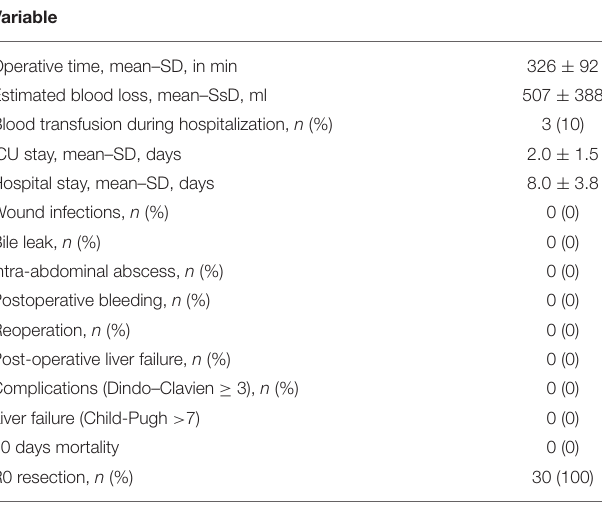
TABLE 1 | Operative variables and postoperative complications.